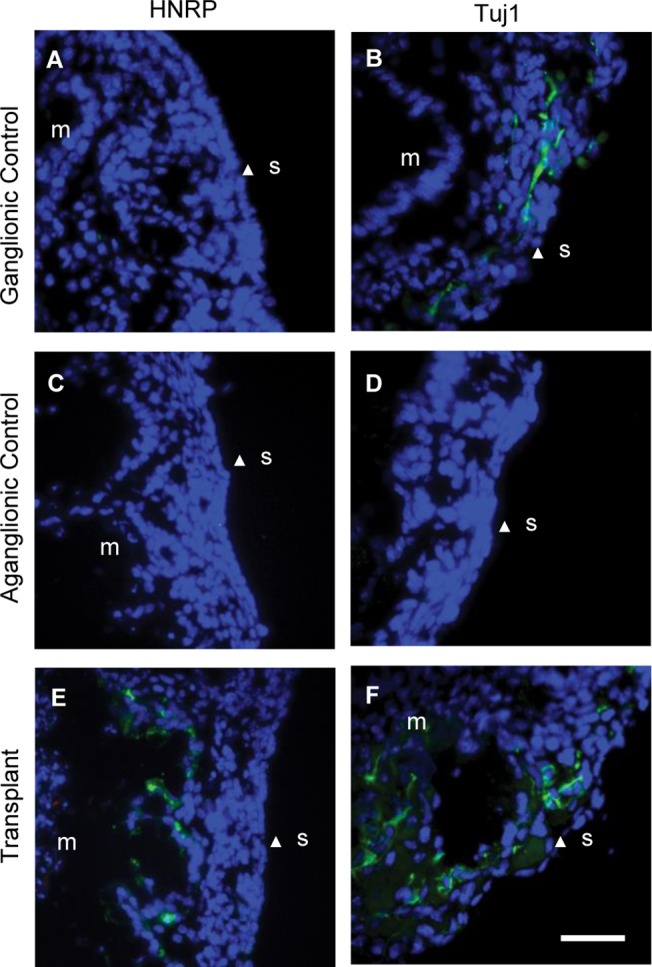
Migration of cells from transplanted neurospheres derived from aganglionic Hirschsprung gut in cultured explants of embryonic mouse colon.Immunofluorescent labeling with human-specific ribonucleoprotein (HRNP) antibody (green) (A, C, E). Human cells were absent in both control ganglionic and aganglionic explants (A, C). HNRP-positive cells had migrated into the developing smooth muscle of aganglionic mouse gut explant after transplantation with human neurospheres (E). Immunofluorescent labeling Tuj1 antibody (green) (B, D, F). Tuj1-positive cells cells were present in the ganglionic mouse gut explant reflecting its endogenous ENS (B). No Tuj1 immunoreactive cells were detected in the aganglionic mouse gut explant (D). Tuj1–positive cells were present in the mouse gut explant after transplantation of the human neurosphere (F). All images are orientated with the serosal surface (S, arrowheads) on the right, and the mucosal/submucosal region (M) of the explant on the left. Scale bar = 50μm.